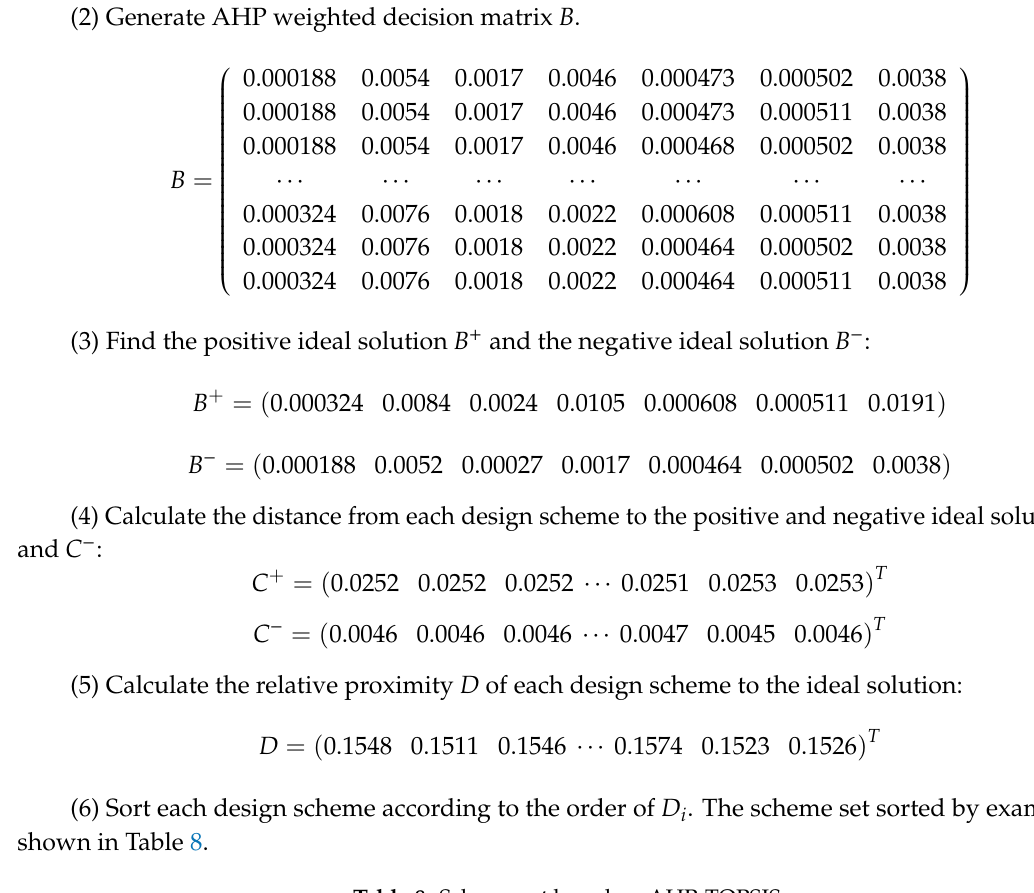
Table 8. Scheme set based on